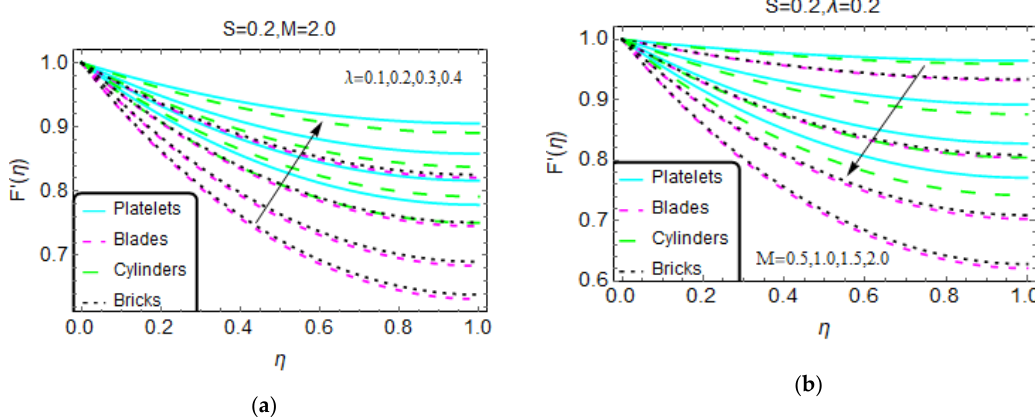
Figure 2. The velocity pattern for different values of ( a ) λ and ( b ) M.